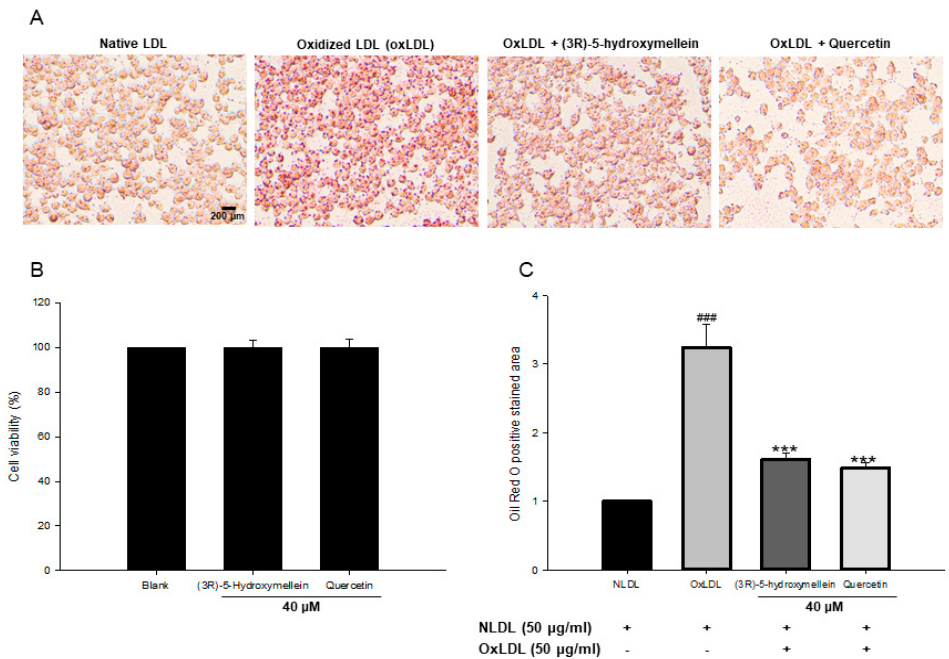
Figure 5. Effects of (3 R )-5-hydroxymellein on oxLDL induced the lipid accumulation in RAW264.7 cells. ( A ) RAW264.7 murine macrophage cells treated with native LDL, oxLDL, and oxLDL with (3 R )-5-hydroxymellein were stained with Oil red O solution. Representative images of Oil red O-stained lipid droplets. ( B ) Cytotoxicity test of (3 R )-5-hydroxymellein in RAW264.7 cells was performed with ELUS cell viability assay kit. ( C ) The Oil Red O positive cells stained area was calculated using the Image J software. Quercetin was used as a positive control. ### p < 0.001 vs. NLDL (native LDL); *** p < 0.001 vs. oxLDL (oxidized LDL).